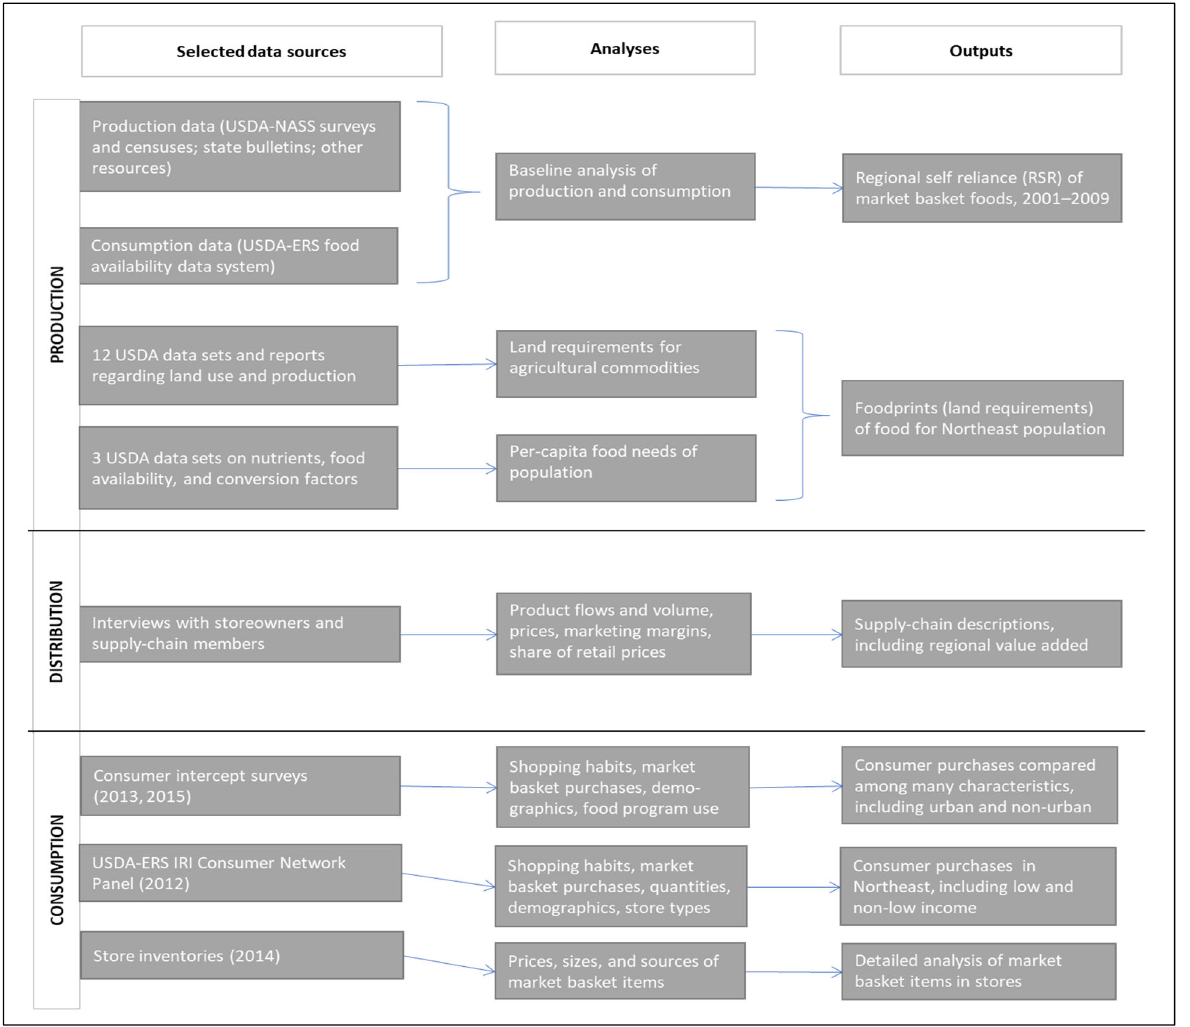
Figure 1. Overview of Data Sources and Methods